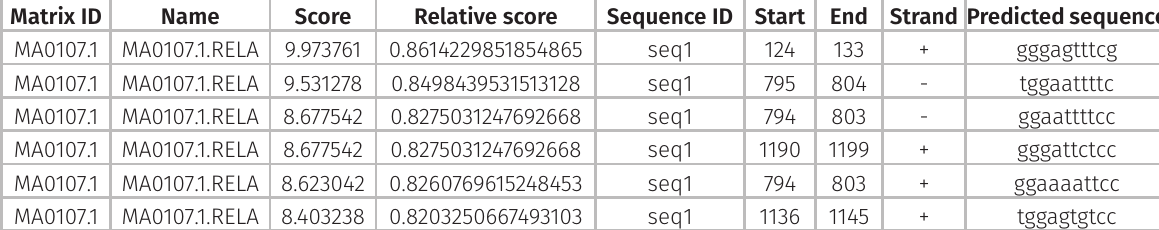
Table IV. Binding of RELA on miR-518a-5p promoter.